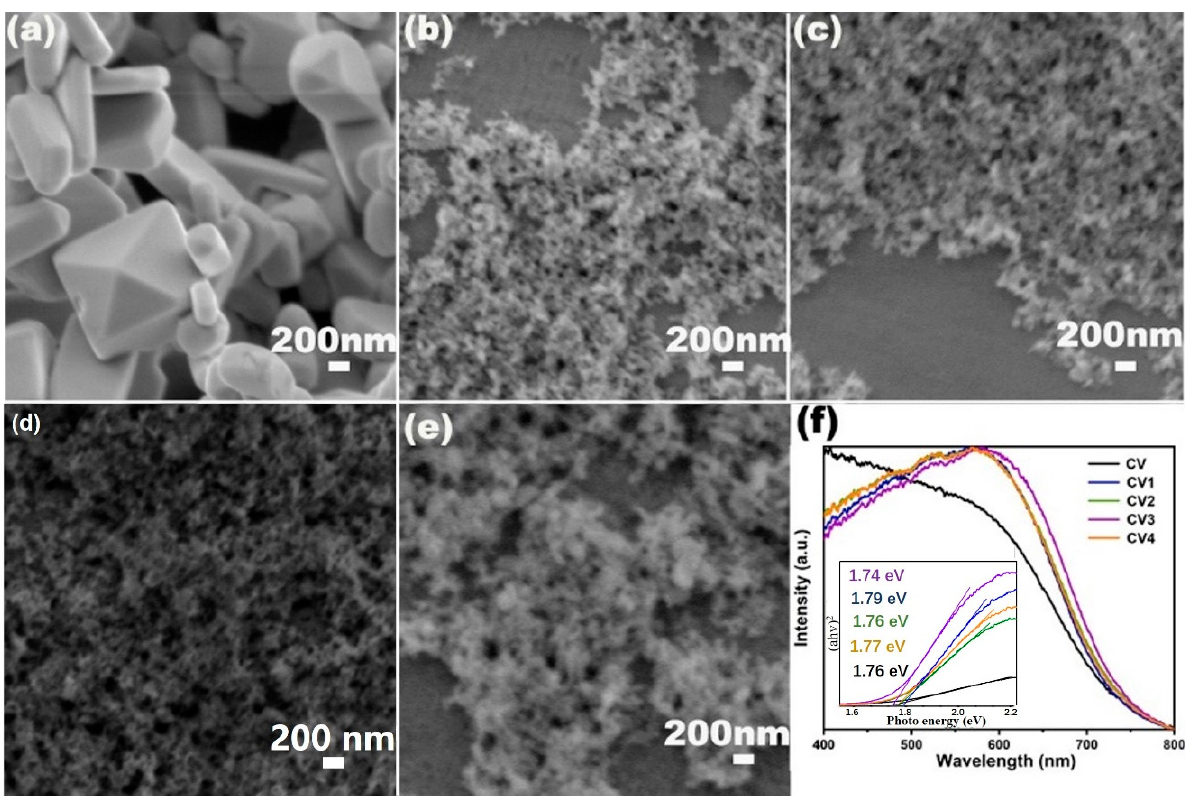
Figure 1. ( a – e ) SEM images of all as-prepared samples CV-CV4, ( f ) Ultraviolet-visible absorption spectra of CV-CV4. (inset plots of ( α h ν ) 1/2 vs. photo energy of CV-CV4).